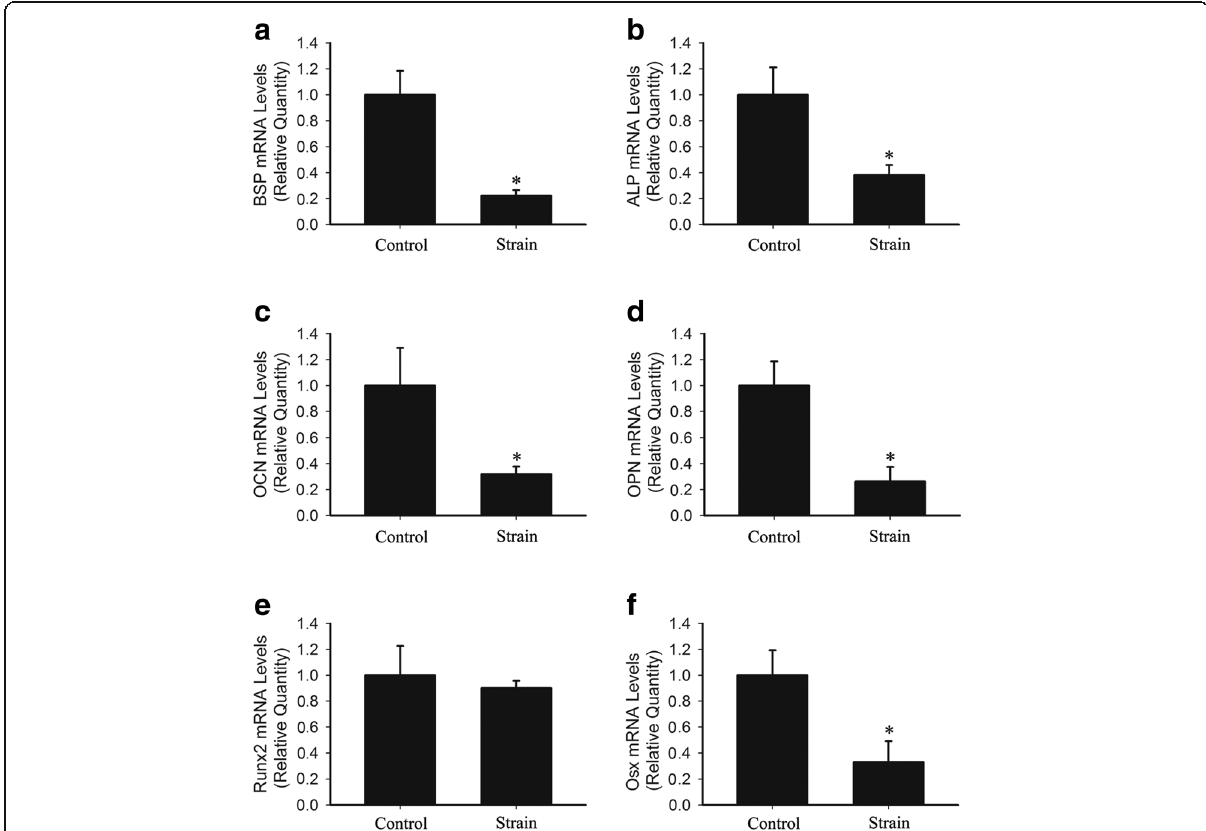
Fig. 6 Mechanical strain impaired gene expression of certain cementogenesis-related biomarkers. a - f The relative mRNA levels of BSP, ALP, OCN, OPN, Runx2 and Osx in OCCM-30 cells in the presence or absence of 18 h mechanical strain. Total RNA was subjected to qPCR. Relative mRNA expression levels were normalized to GAPDH as an endogenous reference. The experiments were repeated 3 times. Bars represent means±SD. * p